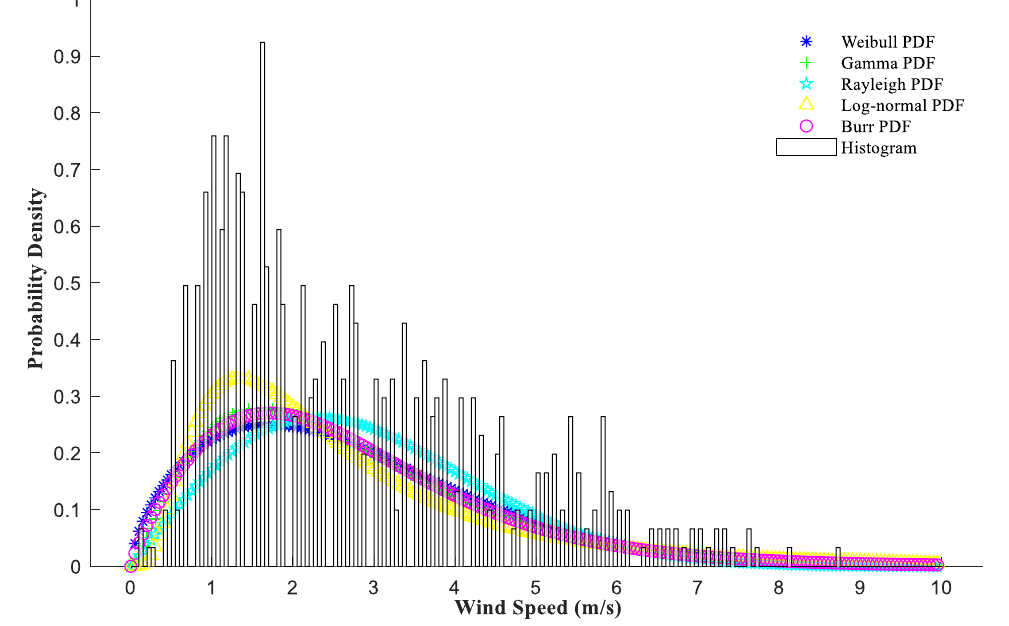
Figure 1. Wind speed distribution.